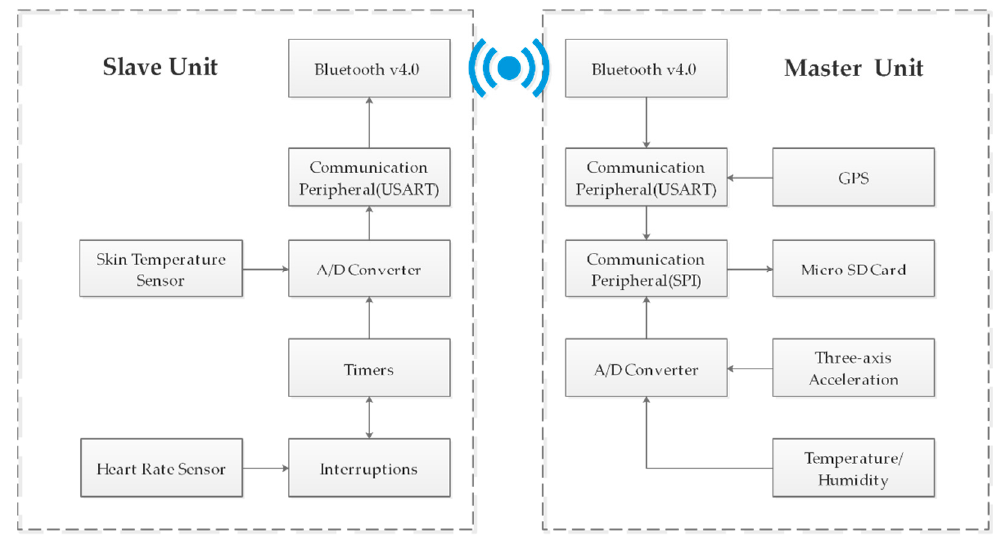
Figure 4. Block diagram of the slave and master units.